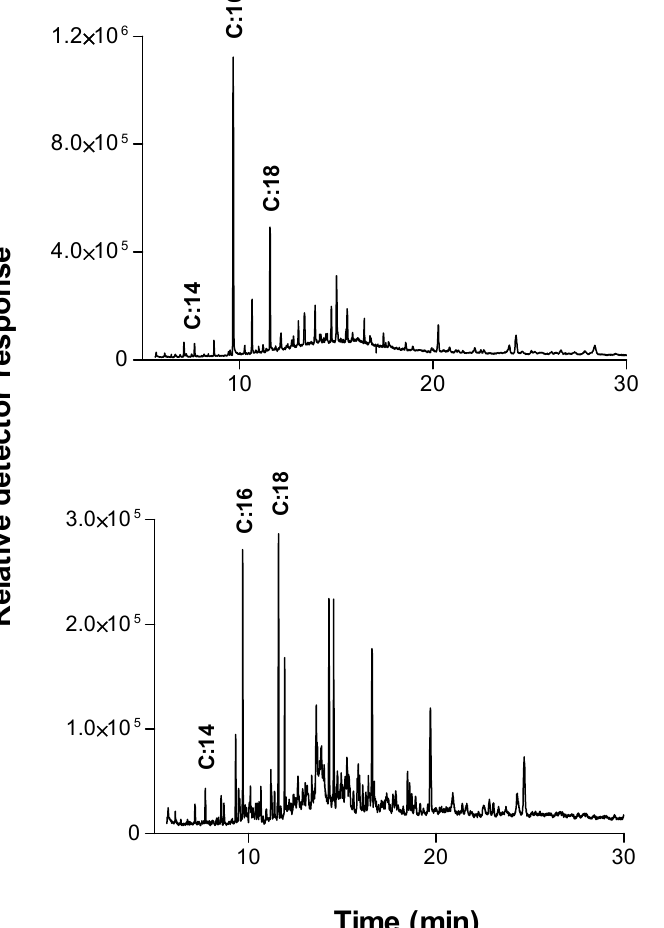
Figure 3. GC-MS analysis of trimethylsilyl derivatives of cutin constituents of cotton fiber. ( A ). Dichloromethane extract of raw cotton swatches with reflux overnight. ( B ). The chloroform extract of the residual reaction solution following incubation of similar pieces of cloth with 19 U/mL cutinase for 23 h. Incubation conditions were: 1 gr fabric swatches, 10 mL reaction mixture containing 100 mM phosphate buffer pH 8 and 0.1% AvcoPal-AWS non-ionic detergent comprised of a blend of polyoxyethylene fatty alcohols (Avco-Chem Ltd., Tel Aviv, Israel), temperature 37 °C in a rotary shaker (175 rpm). C:14, C:16 and C:18 designate tetra, hexa and octadecanoic acids. The most distinctive products found in the reaction fluid upon cutinase hydrolysis (16:0, 18:0) corresponded to the two main DCM extractable constituents of raw cutin.